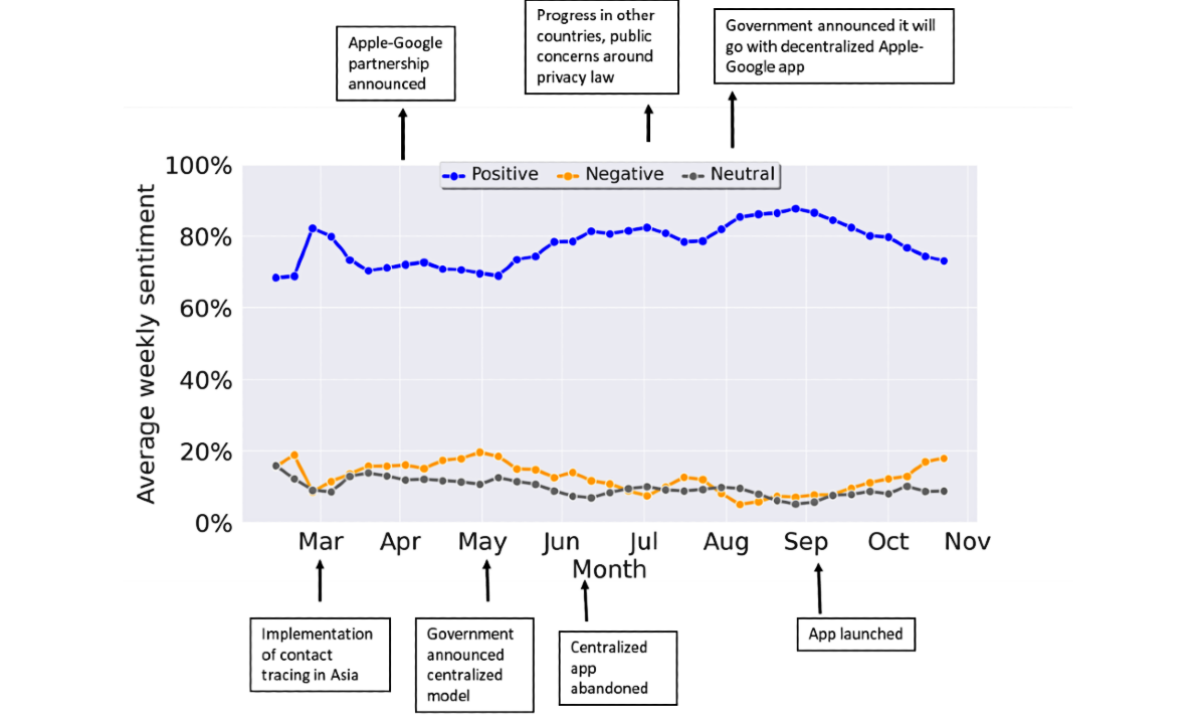
Figure 2. Average weekly sentiments extracted from Facebook and Twitter posts (combined) in the United Kingdom.